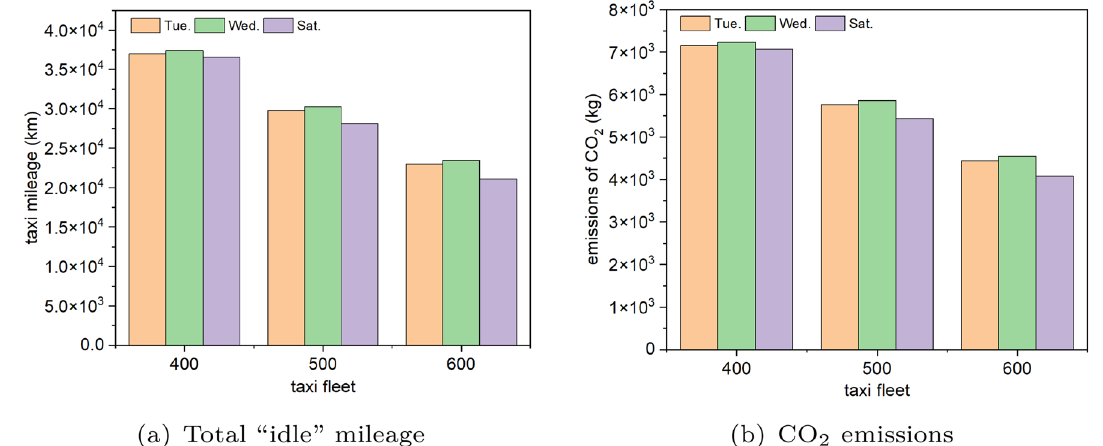
Fig. 25 Analyses of minimum total “idle”